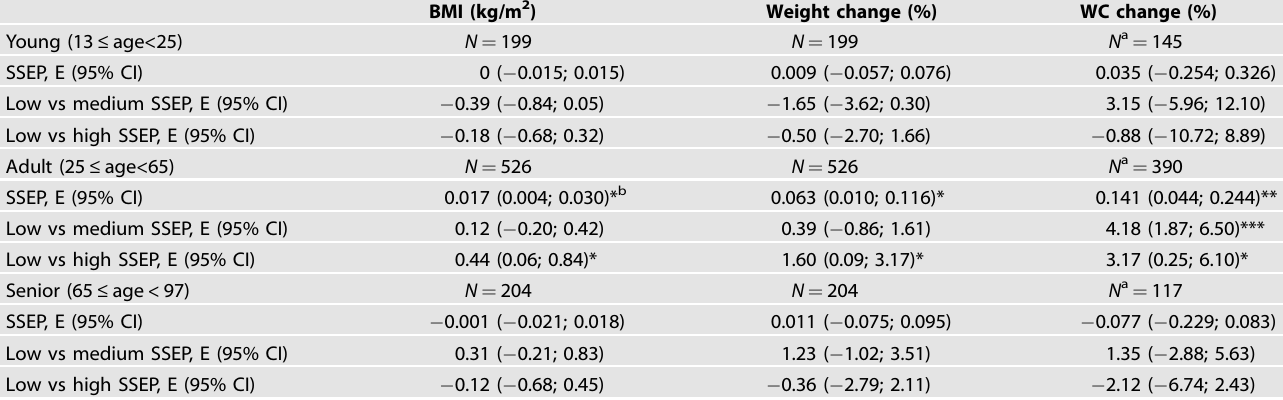
Table 2. Association between SSEP and BMI, weight change, and waist circumference change in the young, adult, and elderly population.